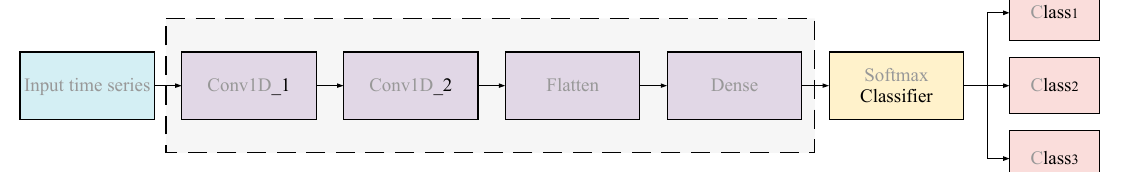
Figure 5. Schematic of a one-dimensional convolutional neural network (CNN).